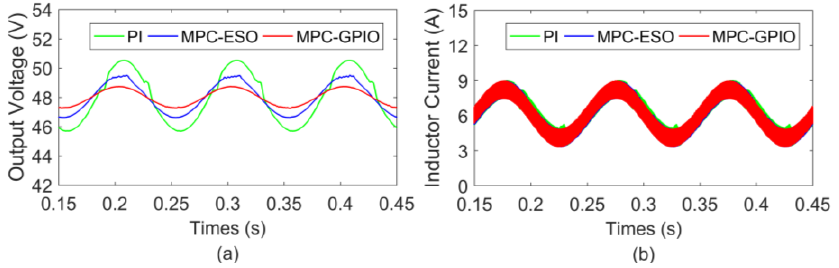
Figure 8. Dynamic response of TIBC with the load current is set as 𝑖 𝑜 = 6 + 2sin(20𝜋𝑡)𝐴: ( a ) output voltage; ( b ) inductor current. voltage; ( b ) inductor